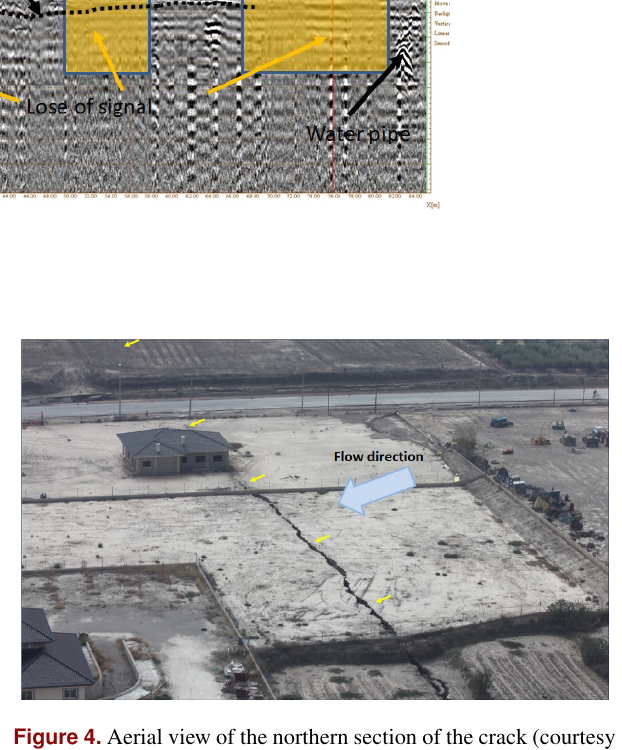
Figure 4. Aerial view of the northern section of the crack (courtesy of Puerto Lumbreras City Council). The yellow arrows indicate the location of the earth fissure (modified from Mulas, 2013).